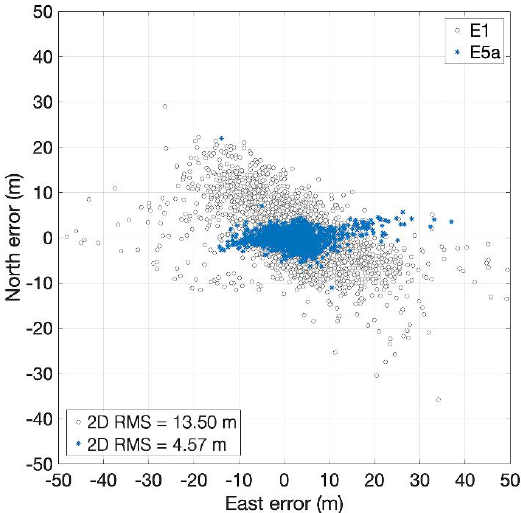
Figure 9. Scatter plot error comparison of single-point positioning between E1 and E5a signals collected by smartphone in the Portici site. Grey markers represent errors when the solution was obtained using Galileo E1 measurements, blue circles represent error for E5a measurements.